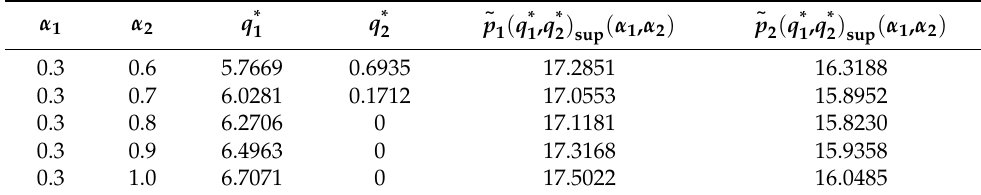
( α 1 , α 2 )-optimistic equilibrium quantity for Scenario II when AG’s risk aversion levels increase.